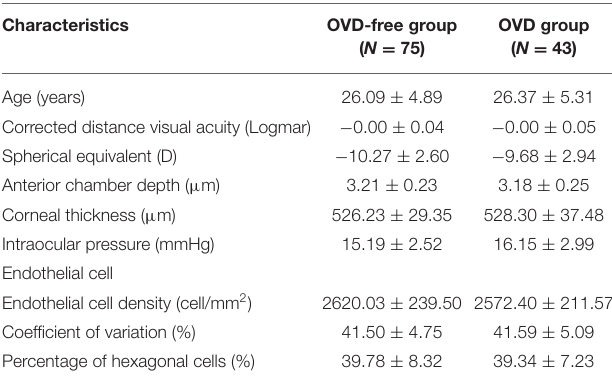
TABLE 1 | Baseline characteristics of the